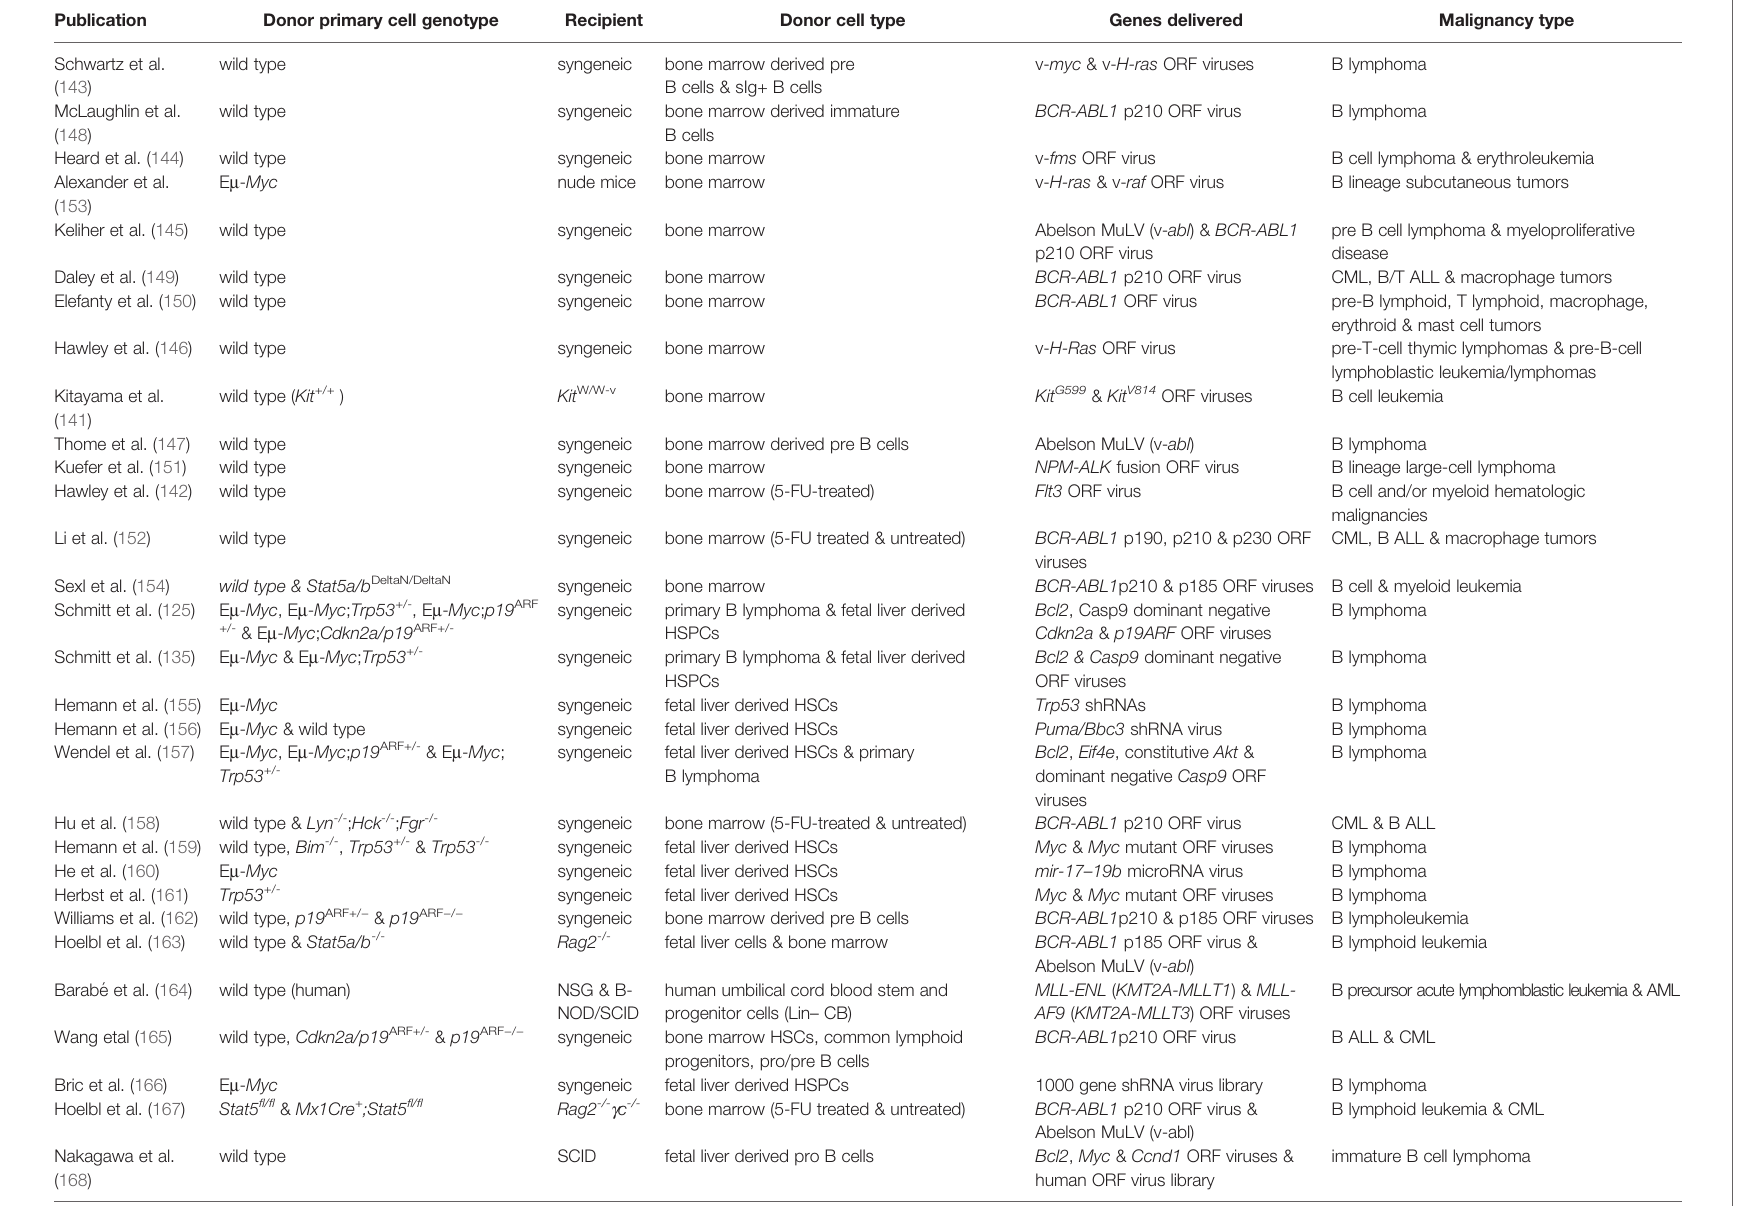
TABLE 4 | Reverse genetic B cell malignancy transplantation assays using primary